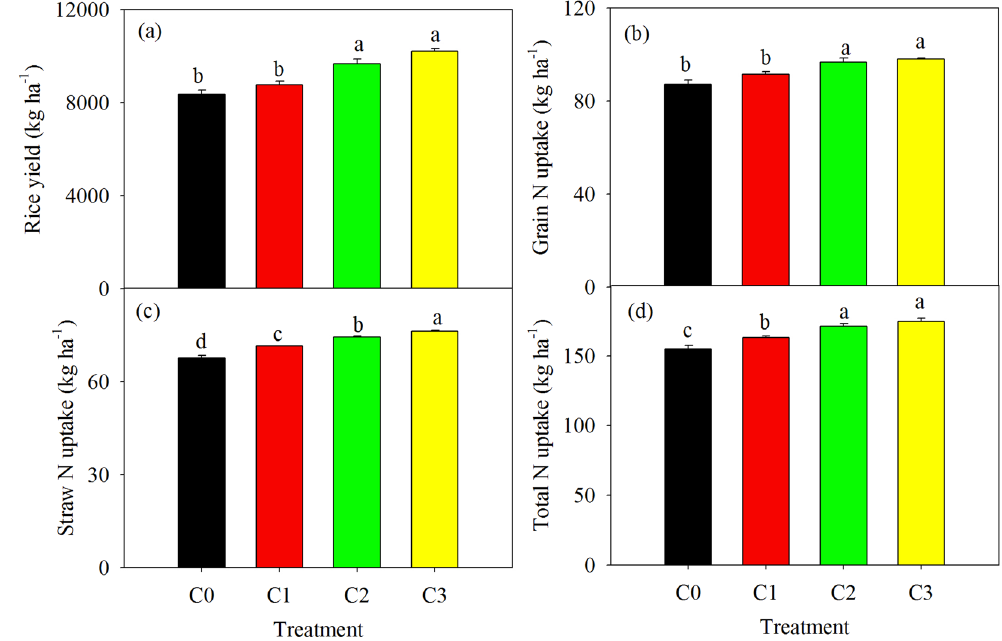
Figure 1. Rice yield ( a ), grain N uptake ( b ), straw N uptake ( c ) and total N uptake ( d ) under the four experimental treatments. Data are shown as means with standard errors. Different letters in the same subfigure indicate significant differences of different treatment according to the LSD test ( P <